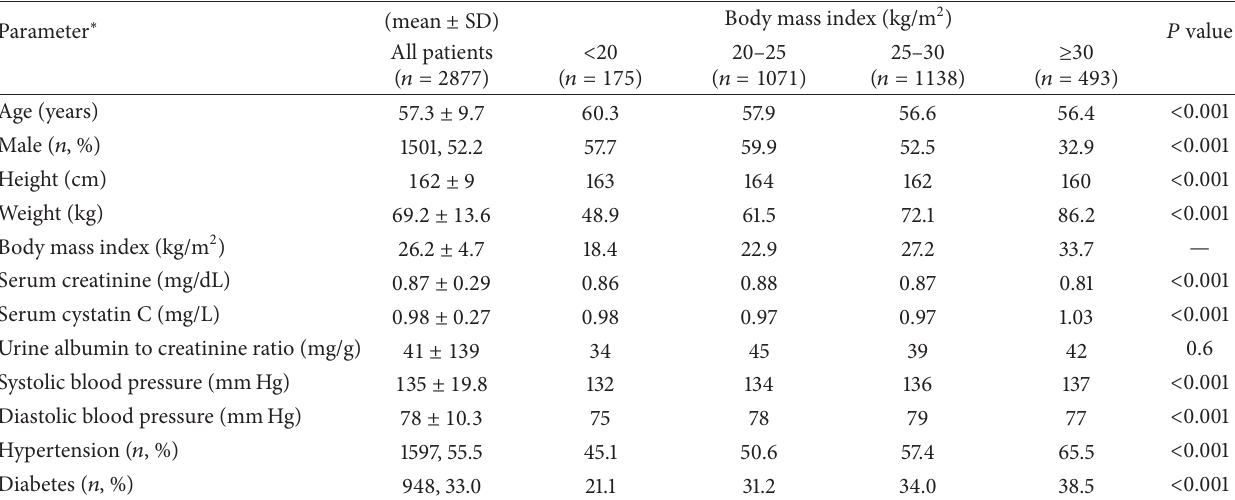
Table 1: Demographics and